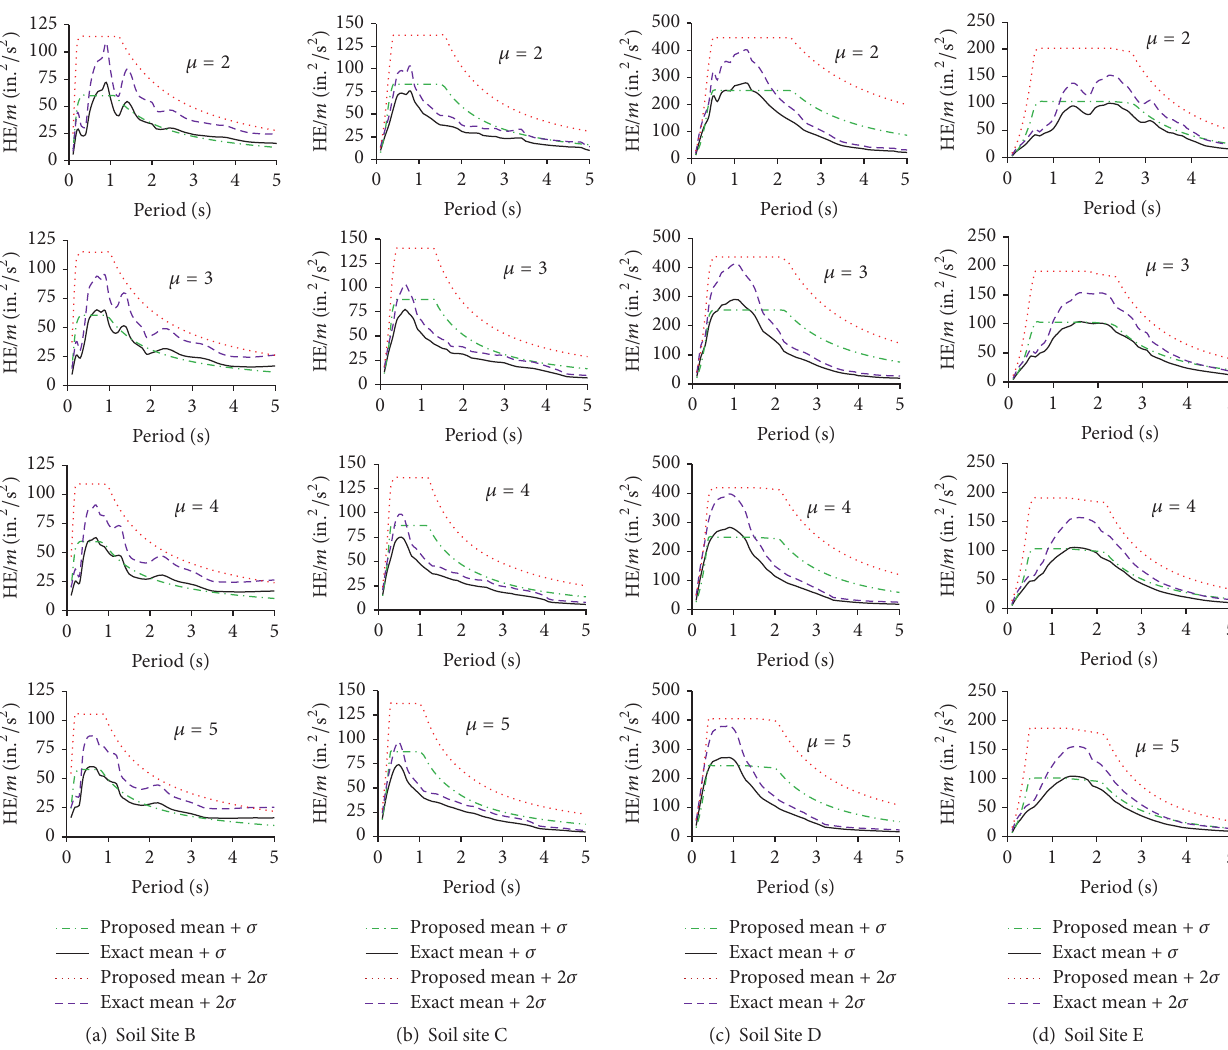
Figure 14: Comparative study of proposed hysteretic energy spectra: hysteresis model